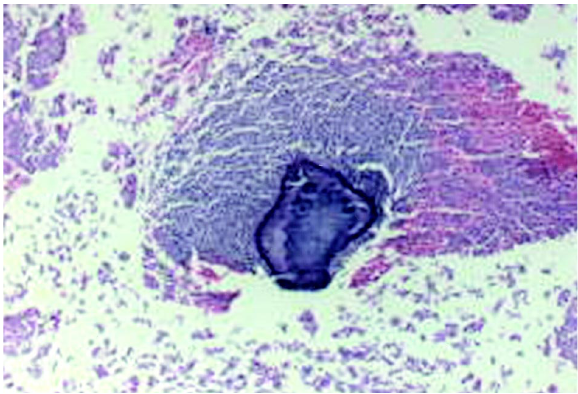
Figure 3 – Computed tomography (CT) showing a cystic mass anterior to the